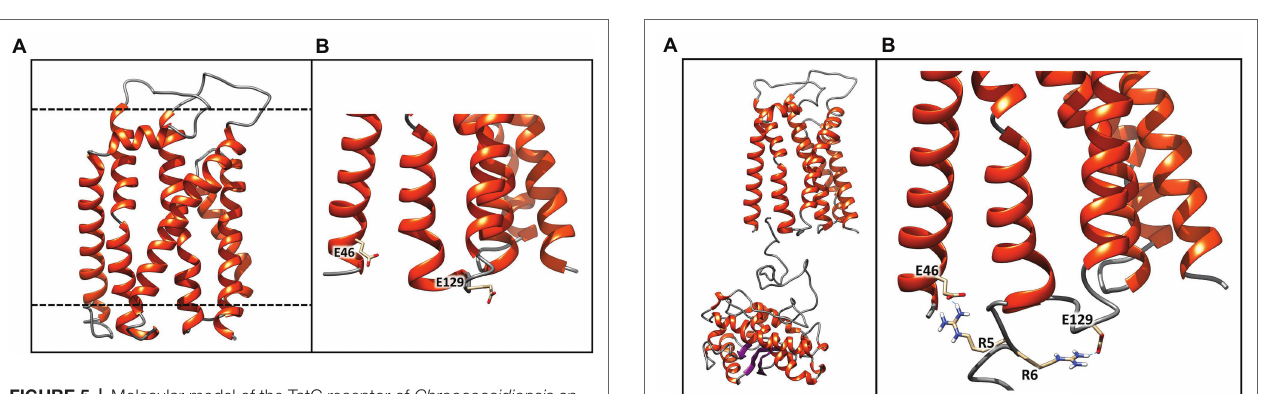
FIGURE 5 | Molecular model of the TatC receptor of Chroococcidiopsis sp. CCMEE 029. (A) Model generated using as a template the crystal structure of twin arginine translocase receptor from Aquifex aeolicus (PDB ID: 4HTS). α -helices and loops are represented by orange spirals and light gray wires, respectively. (B) The dashed lines indicate the transmembrane region Glu46 and Glu129 would coordinate the positively charged guanidinium groups of the sequential arginine residues of the Tat signal peptide. This image was generated using the Chimera